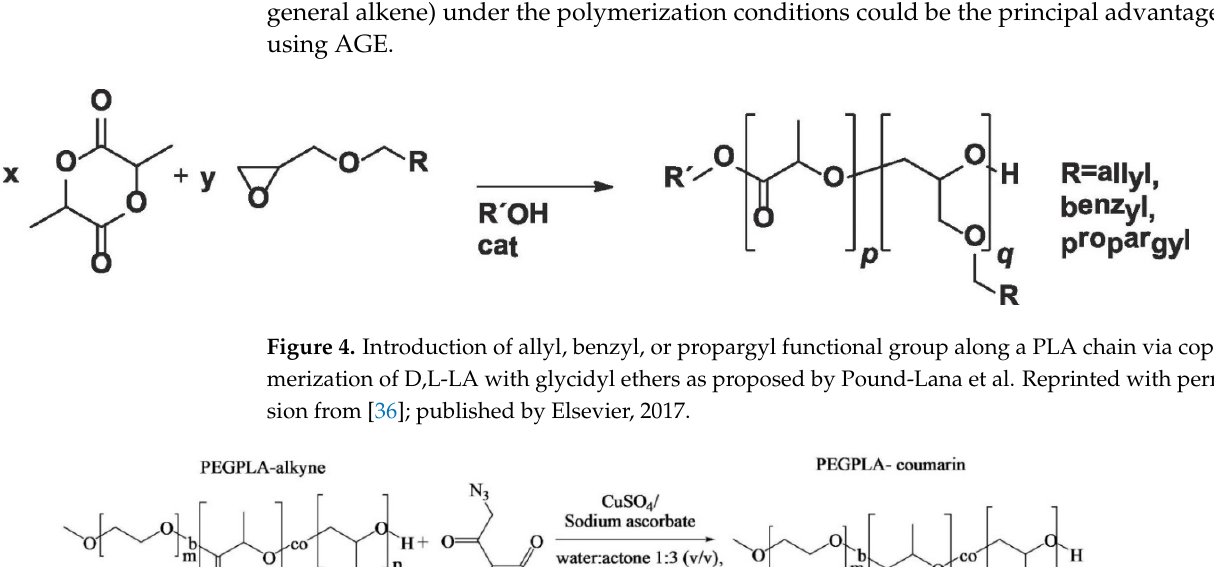
Figure 5. Reaction scheme for the preparation of alkyne-functional PEG- b -P(LA- co -PGE)-coumarin conjugate as described by Pound-Lana et al. Adapted with permission from [36]; published by Elsevier, 2017.